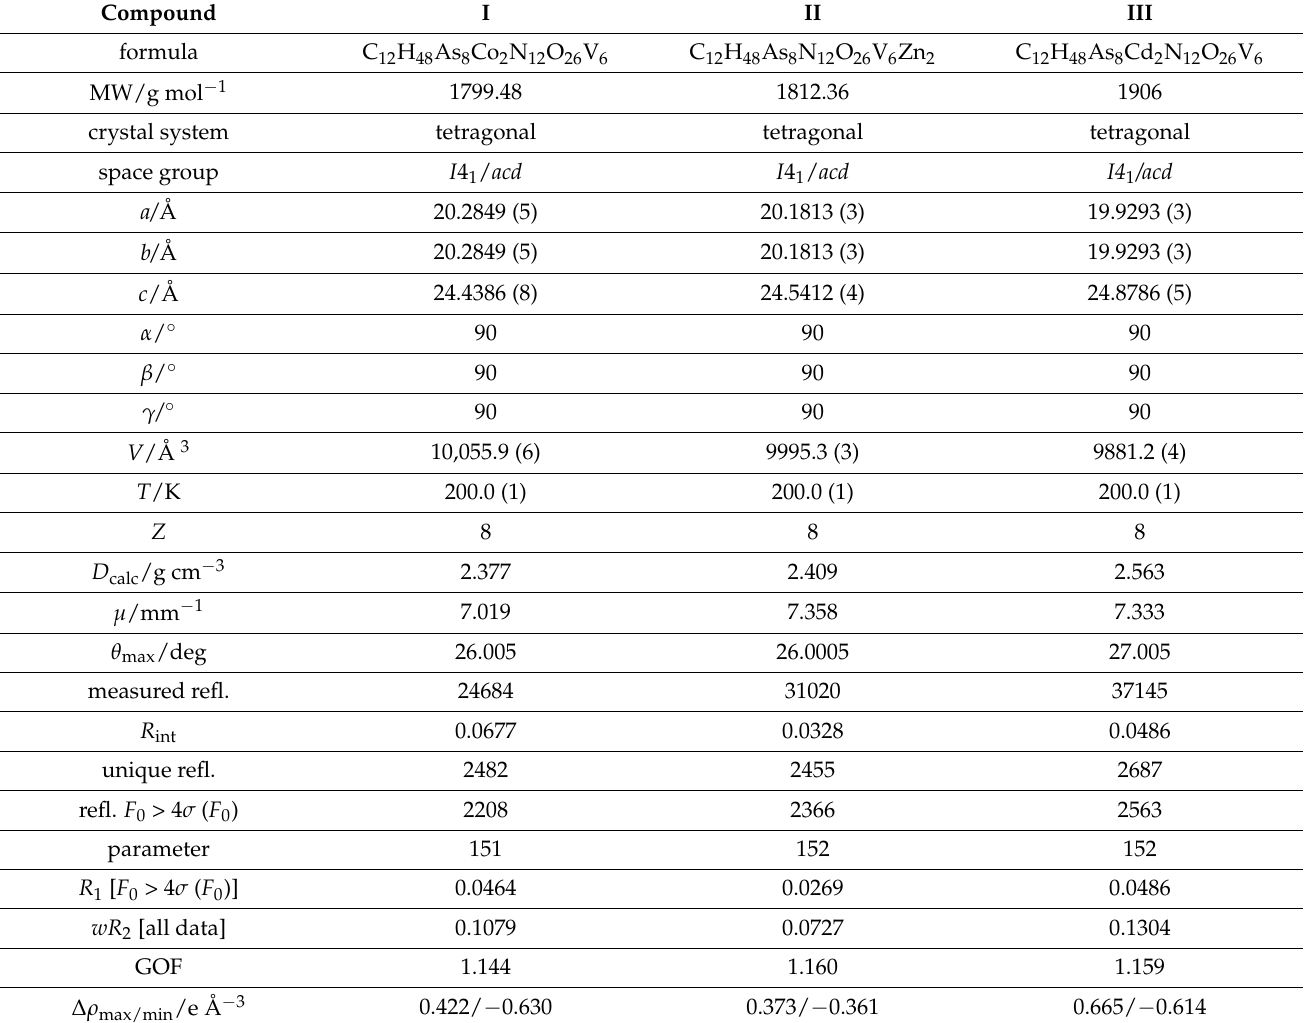
Table 1. Selected crystal data and details of the single crystal structure refinements for I, II, and